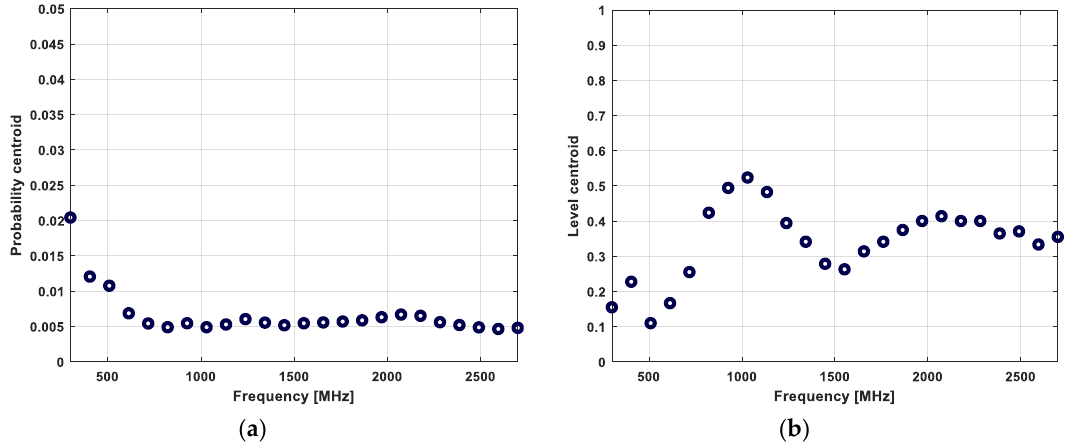
Figure 15. Histograms centre of mass. ( a ) Level probability versus frequency; ( b ) Level occurrence versus frequency.